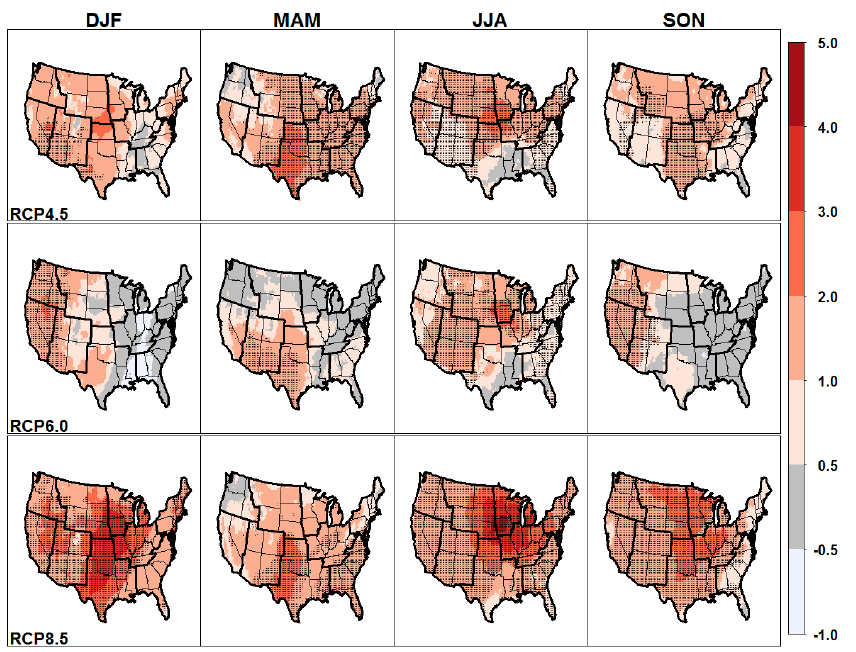
Figure 10. Projected changes in seasonal averages of daily maximum 2m temperature (K) from 1995–2005 to 2025–2035 under RCP4.5, RCP6.0, and RCP8.5. Dark pixels indicate where differences are significant according to Student’s t test ( p < 0 . 05).